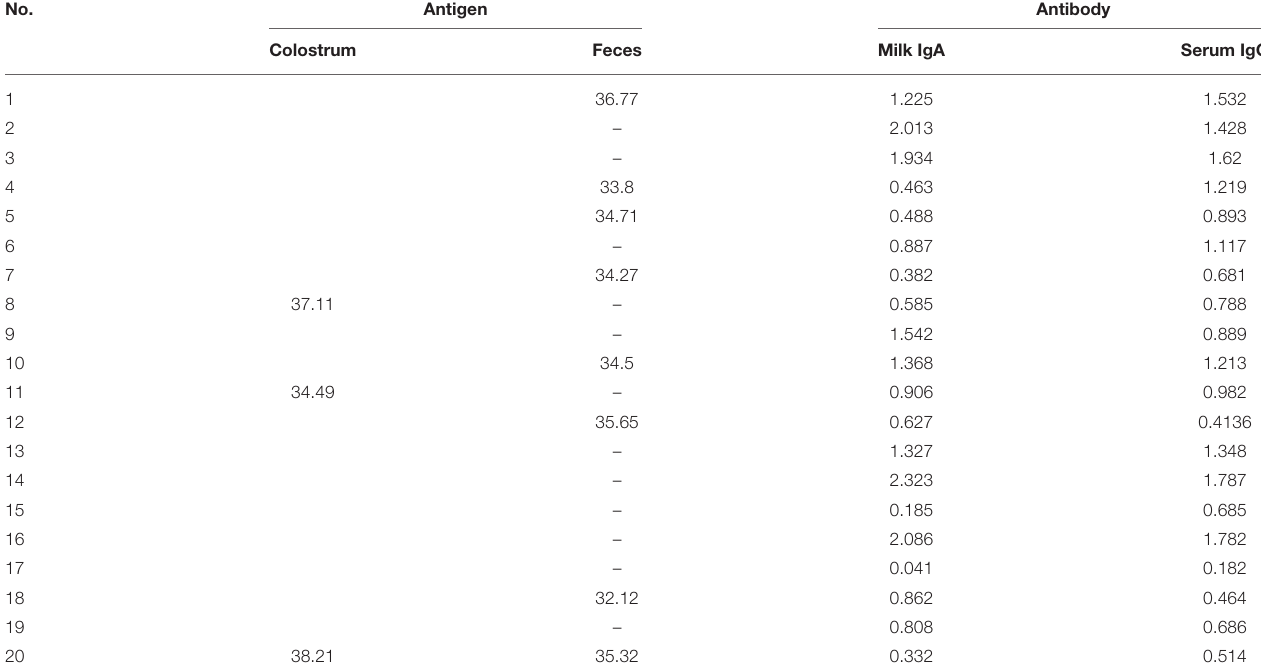
TABLE 2 | Analysis of antibody and virus shedding of infected sows. No.